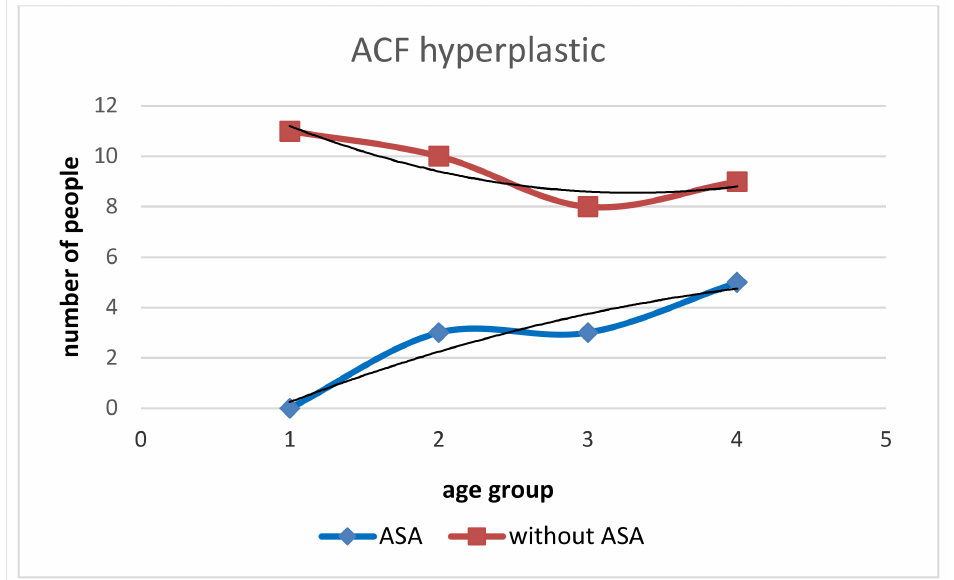
Figure 4. Incidence of hyperplastic ACF in the group with ASA and without ASA. The number of hyperplastic ACFs in subjects without ASA is greater than those with ASA. In subjects without ASA, the number and increment of hyperplastic ACFs gradually decrease with age. In subjects with ASA, the number and increment of hyperplastic ACFs increases with age. The difference in the number of hyperplastic ACFs between with ASA and without ASA decreases with age, but even after age 70 there are more in those without